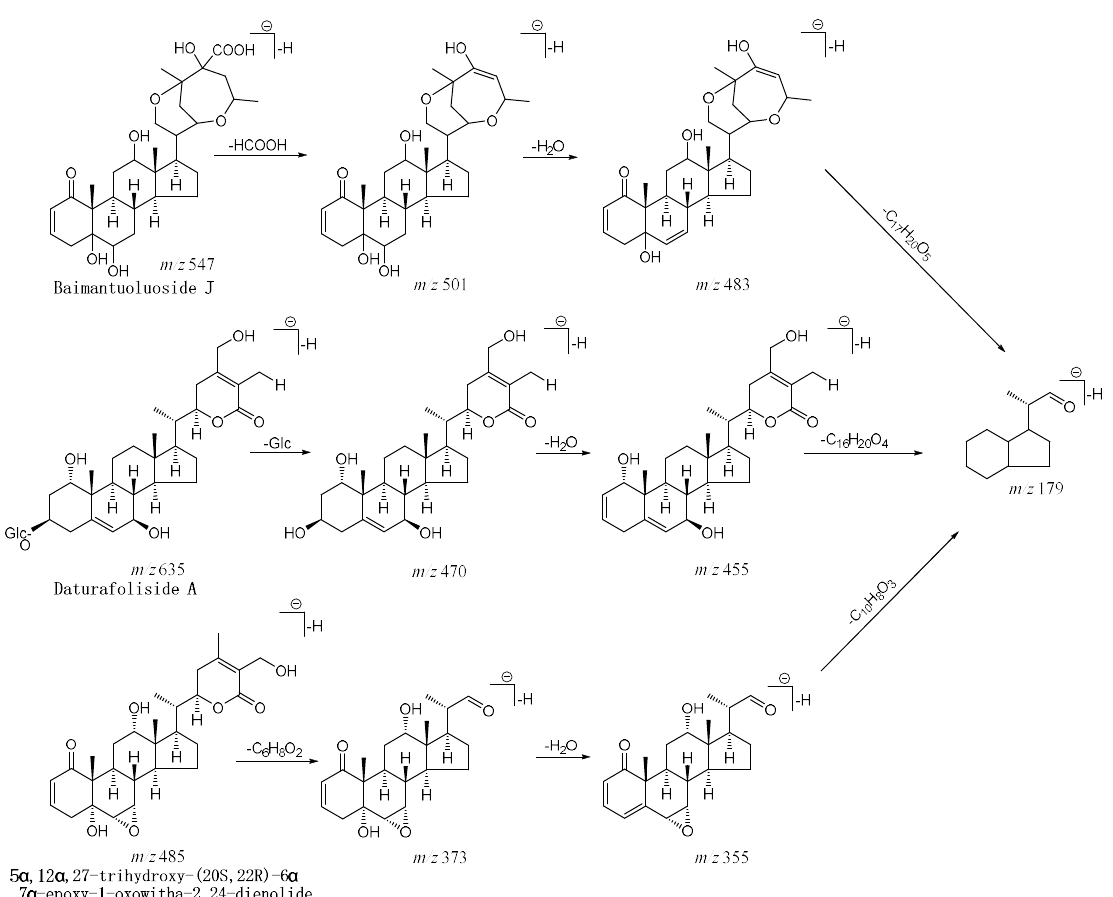
Figure 1. The proposed fragmentation pathways of three example withanolides from Datura metel L. ( D. metel L.).